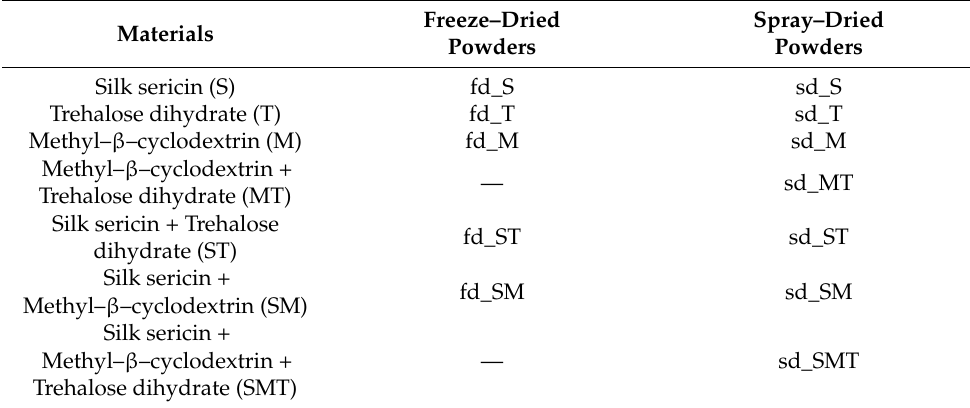
Table 2. Percentage moisture content in fd_ and sd_powders and spray–drying process yields. Data are reported as mean value and standard deviation ( n = 3). Freeze–Dried Spray–Dried Materials Powders